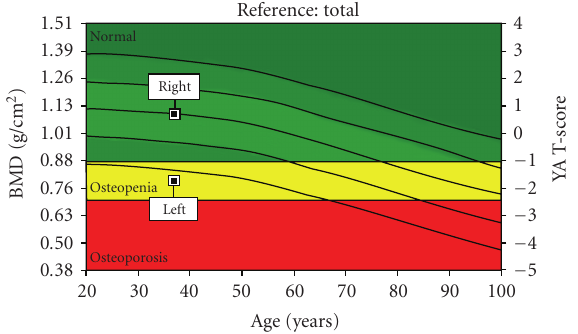
Figure 2: Plot of the BMD against NHANES III reference data for the left and right hips, demonstrating the marked di ff erence between the